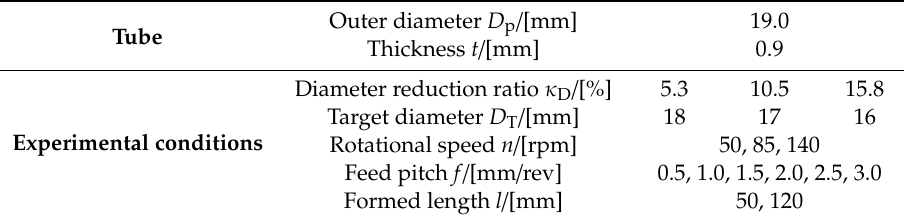
Figure 3. Schematic diagram of scribe lines on the tube.